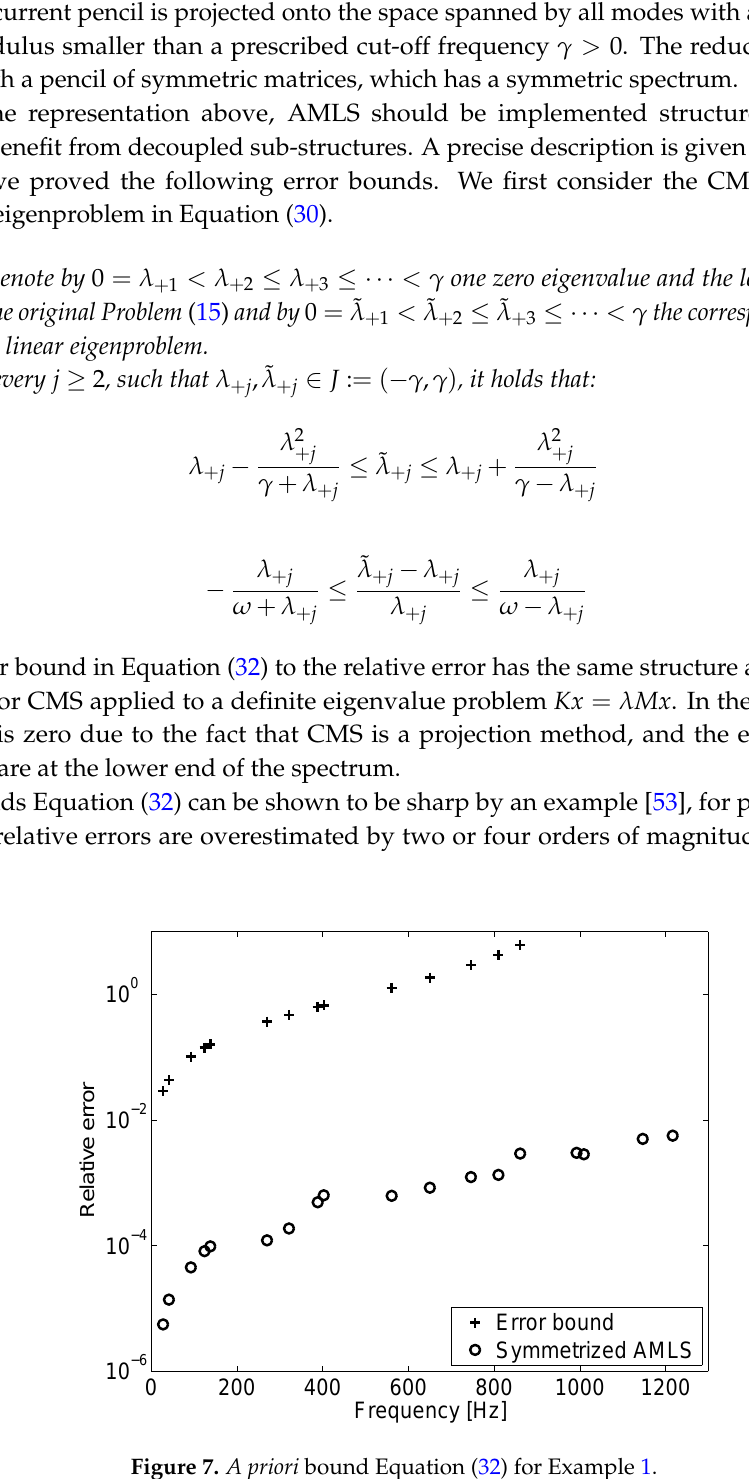
Figure 7. A priori bound Equation (32) for Example